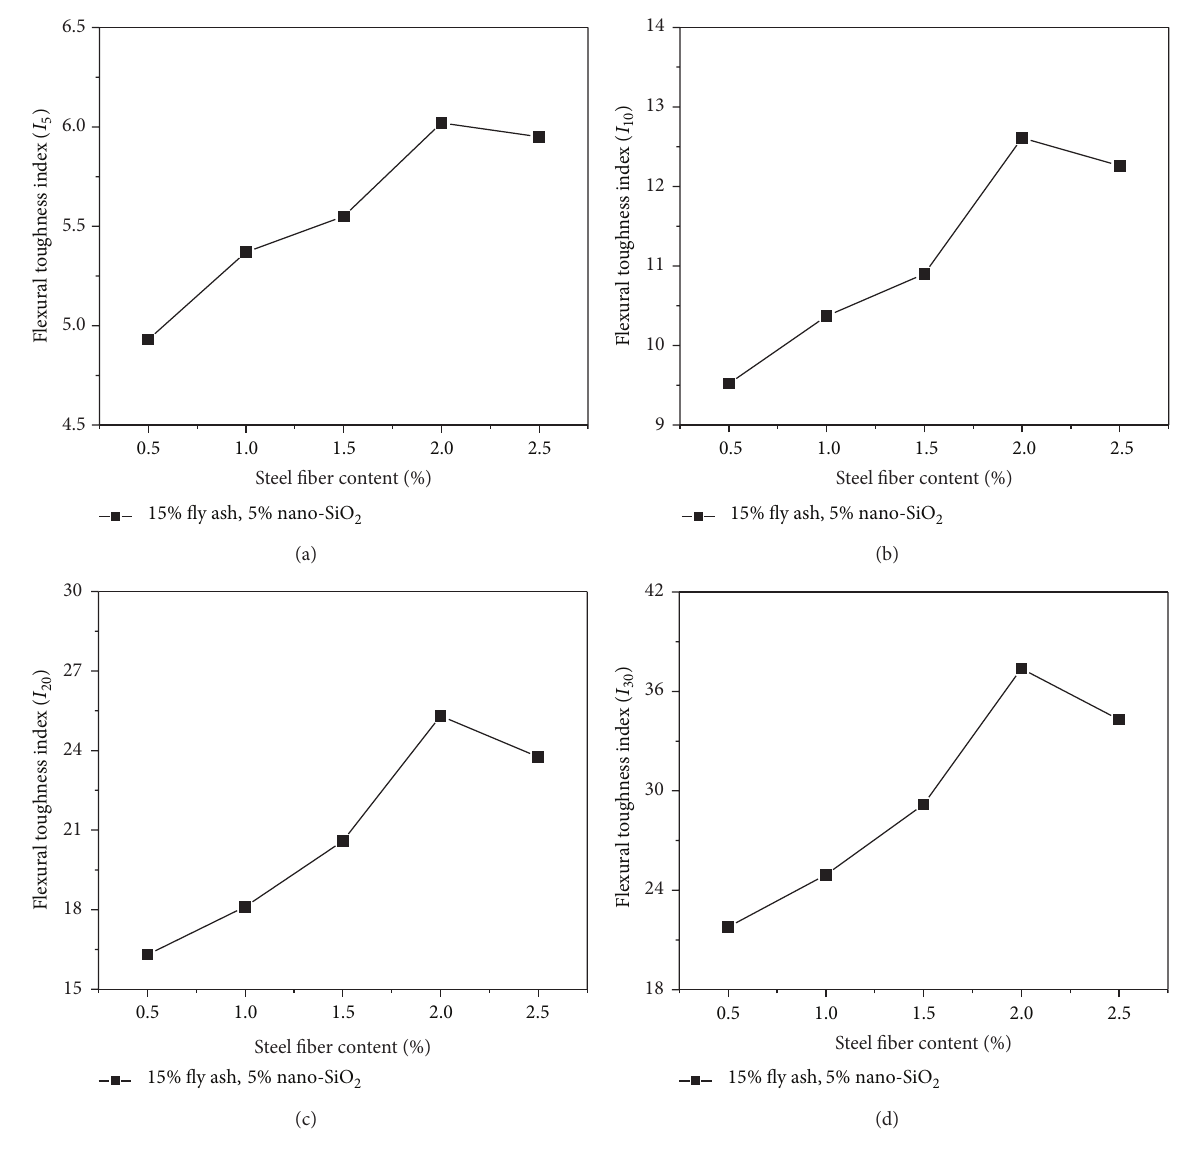
Figure 5: : Effect of steel fiber content on flexural toughness